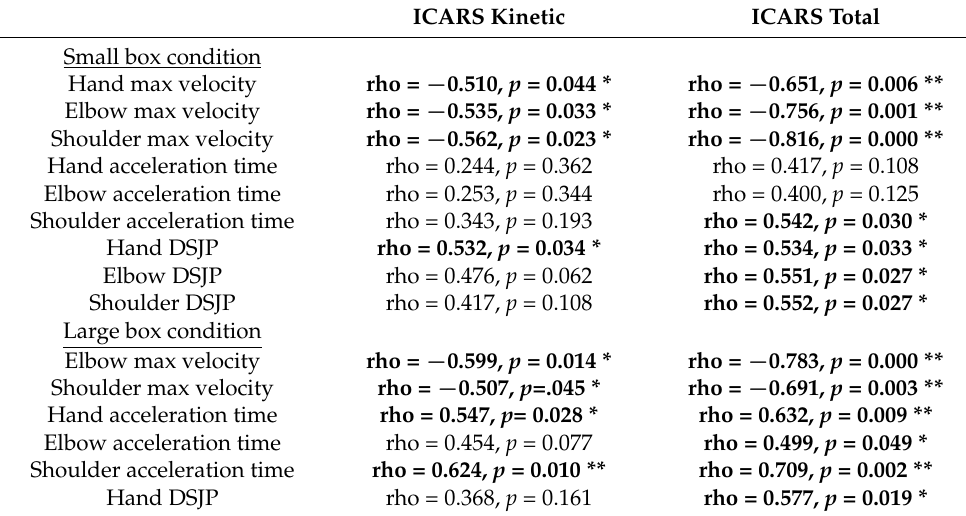
Table 5. Correlation between reaching and clinical characteristics for the premutation carriers. ICARS Kinetic ICARS Total Small box